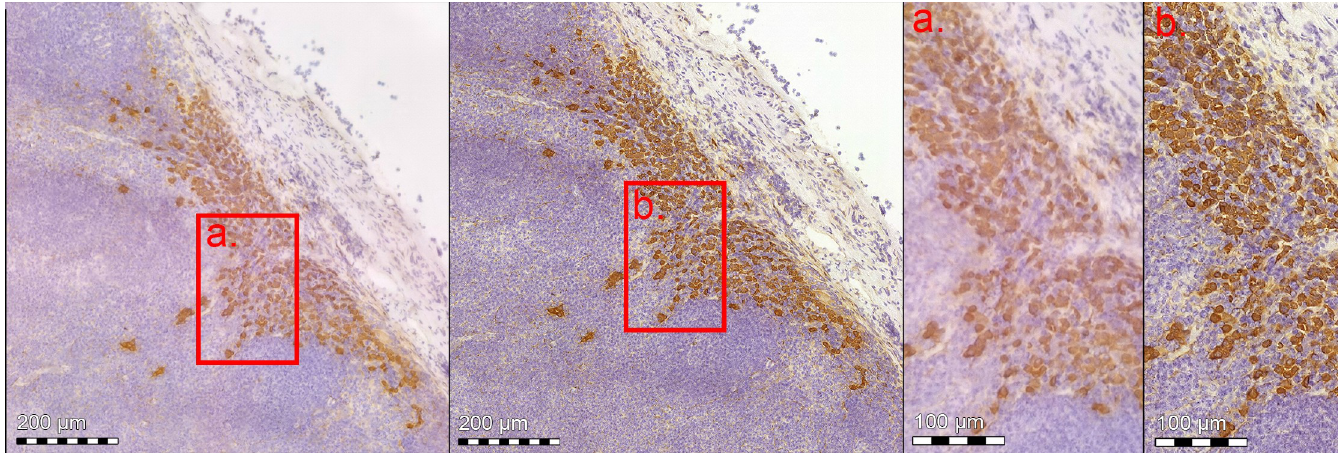
Fig 5. Anti-cytokeratin stained frozen section with micrometastasis. Slide scanned with miniature microscope scanner (left), and reference slide scanner (right). Red bounding box showing higher magnification (a. miniature scanner, and b. reference slide scanner).